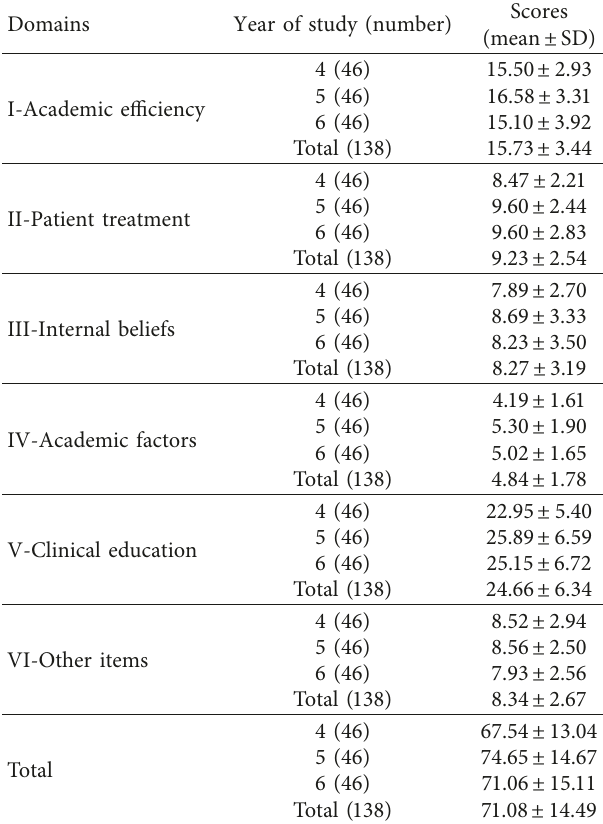
Table 1: The mean scores of the 6 domains of the DES